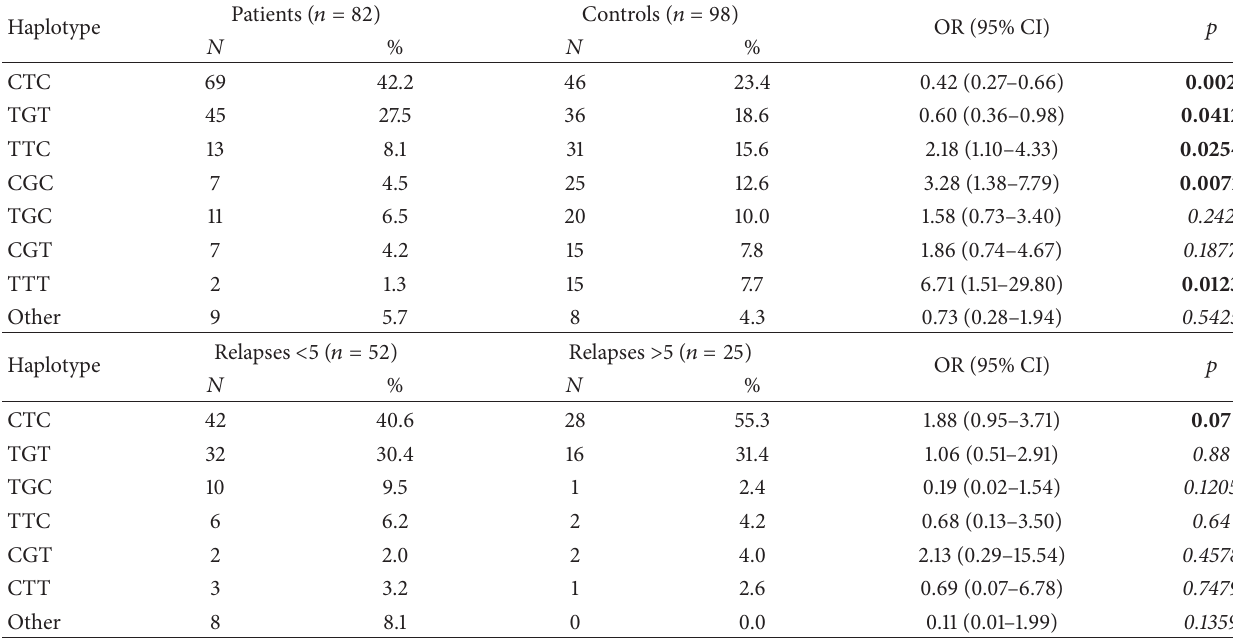
Table 6: Comparison of haplotype distributions of the MDR1 loci in patients and controls as well as in patients with less than 5 relapses and patients with five or more relapses. Variants in order rs1128503, rs2032582, and rs1045642. 𝑝 values lower than 0.05 are marked with ∗